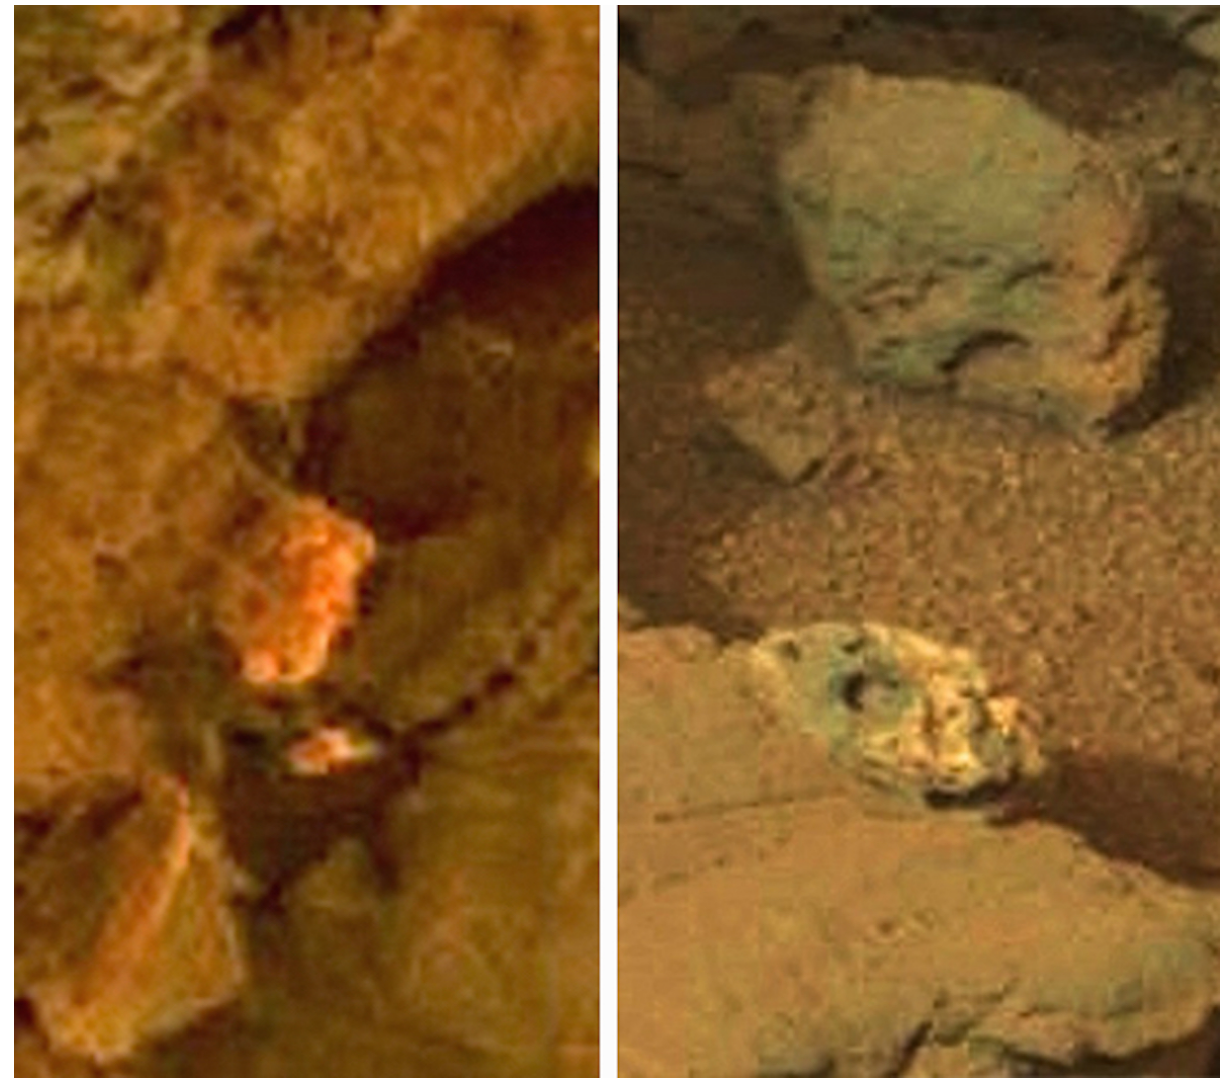
Figure 10. Mars. Sol 305 and Sol 305. Algae-like substances upon fungal-tubular-like specimens, and forming thin layers upon adjacent rocks. Photographed in Gale Crater. (Reproduced with permission from Joseph et al.